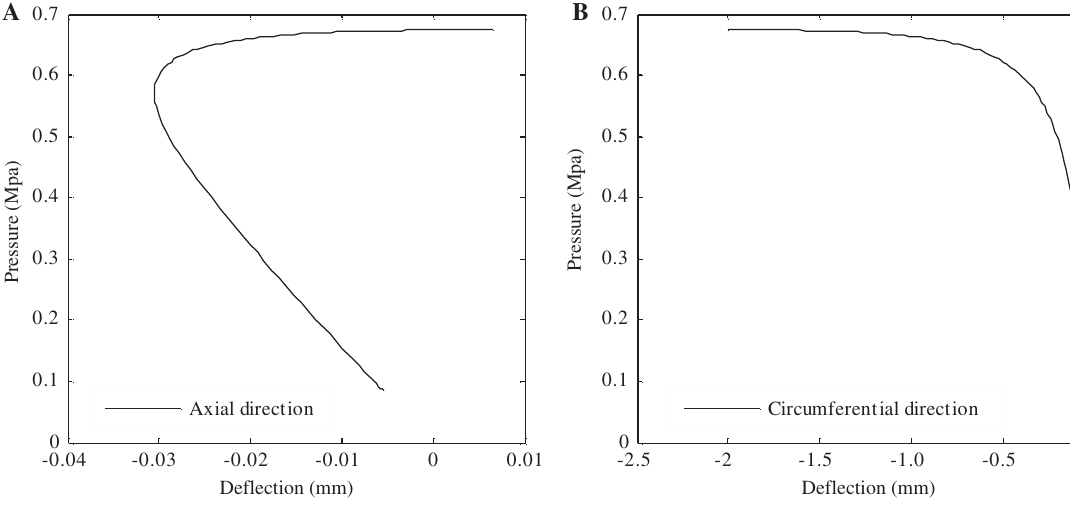
Figure 5: Typical pressure vs. deflection curves at point O (CTM3). (A) Axial direction. (B) Circumferential direction.